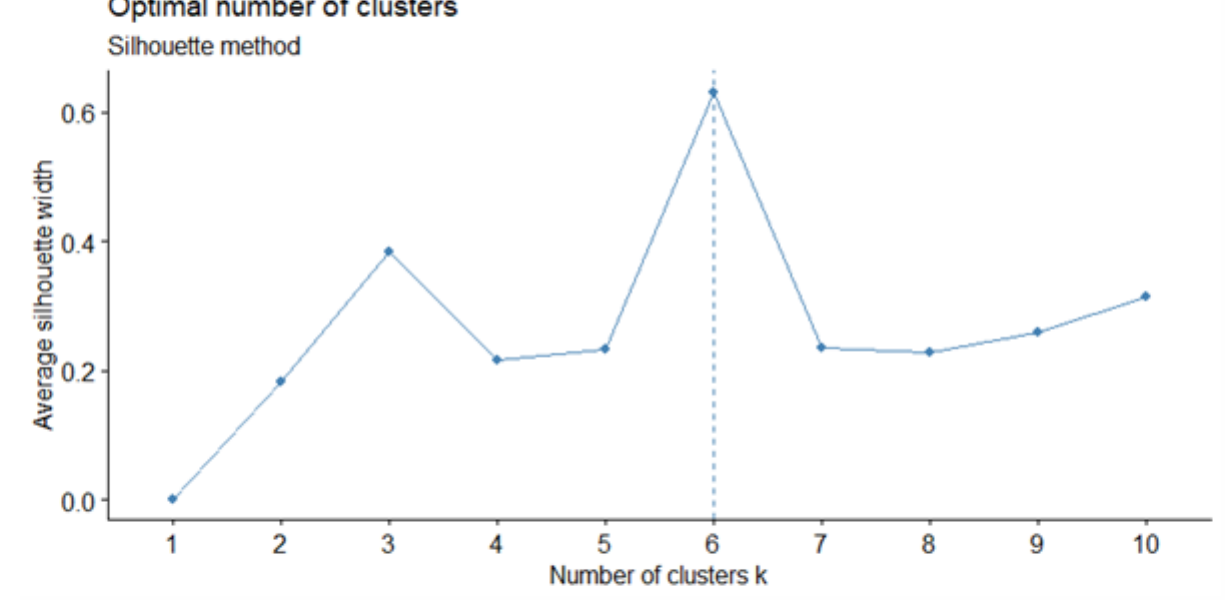
Figure 6. Health impairments sub-cluster: silhouette statistics for choosing the number of groupings suggested the four-cluster grouping